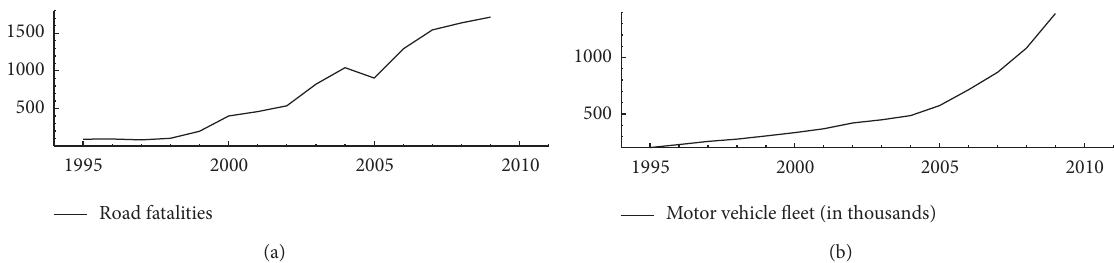
Figure 1: Plots of observed numbers of fatalities (a) and of number of motor vehicles in thousands (b) in Cambodia for the years